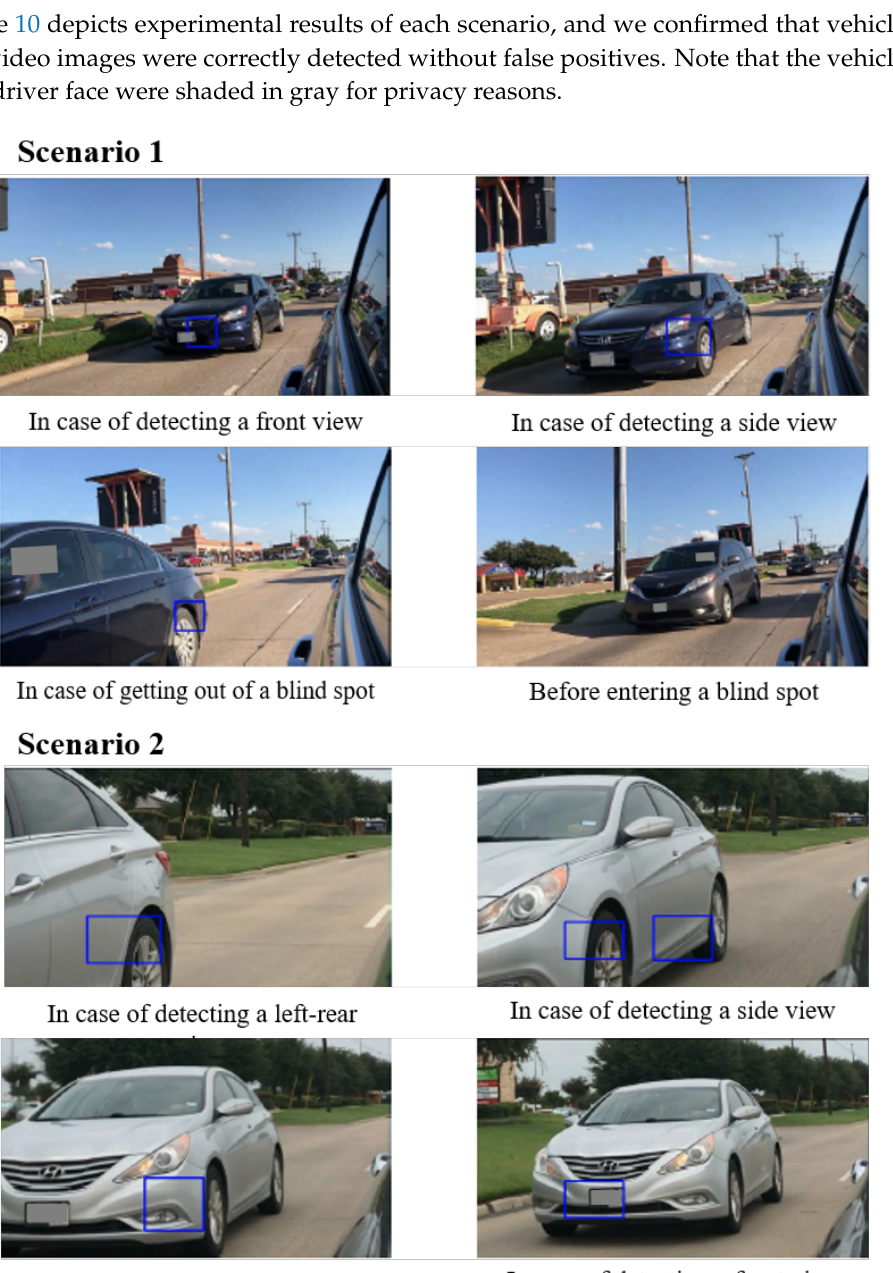
Figure 10. Experimental results of both